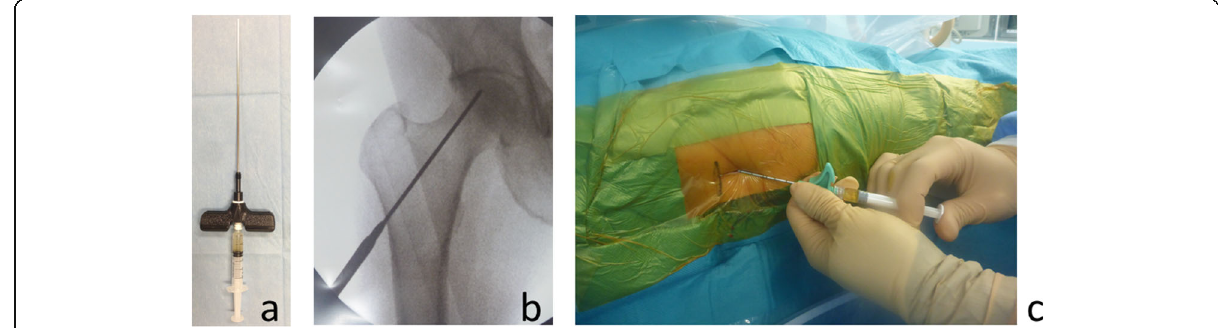
Fig. 4 Percutaneous administration of growth factors into the femoral head. Local injection can be percutaneously administered to the target site. This reduces the operating time and damage to surrounding tissue and enables surgery to be minimally invasive. a A syringe with long needle available for percutaneous administration. b An intraoperative radiographic image reaching to the target site. c An intraoperative photograph when pushing the plunger to